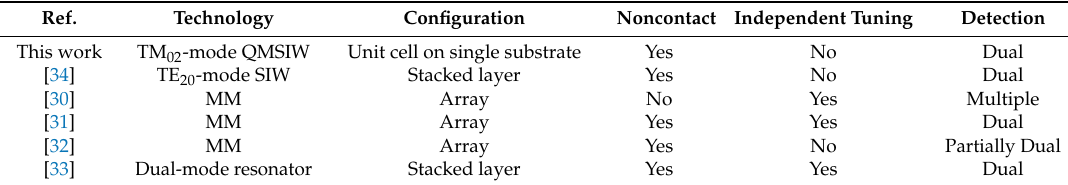
Table 5. Qualitative features of our proposed TM 02 -mode QMSIW resonator along with other microwave chemical sensors capable of dual/multiple